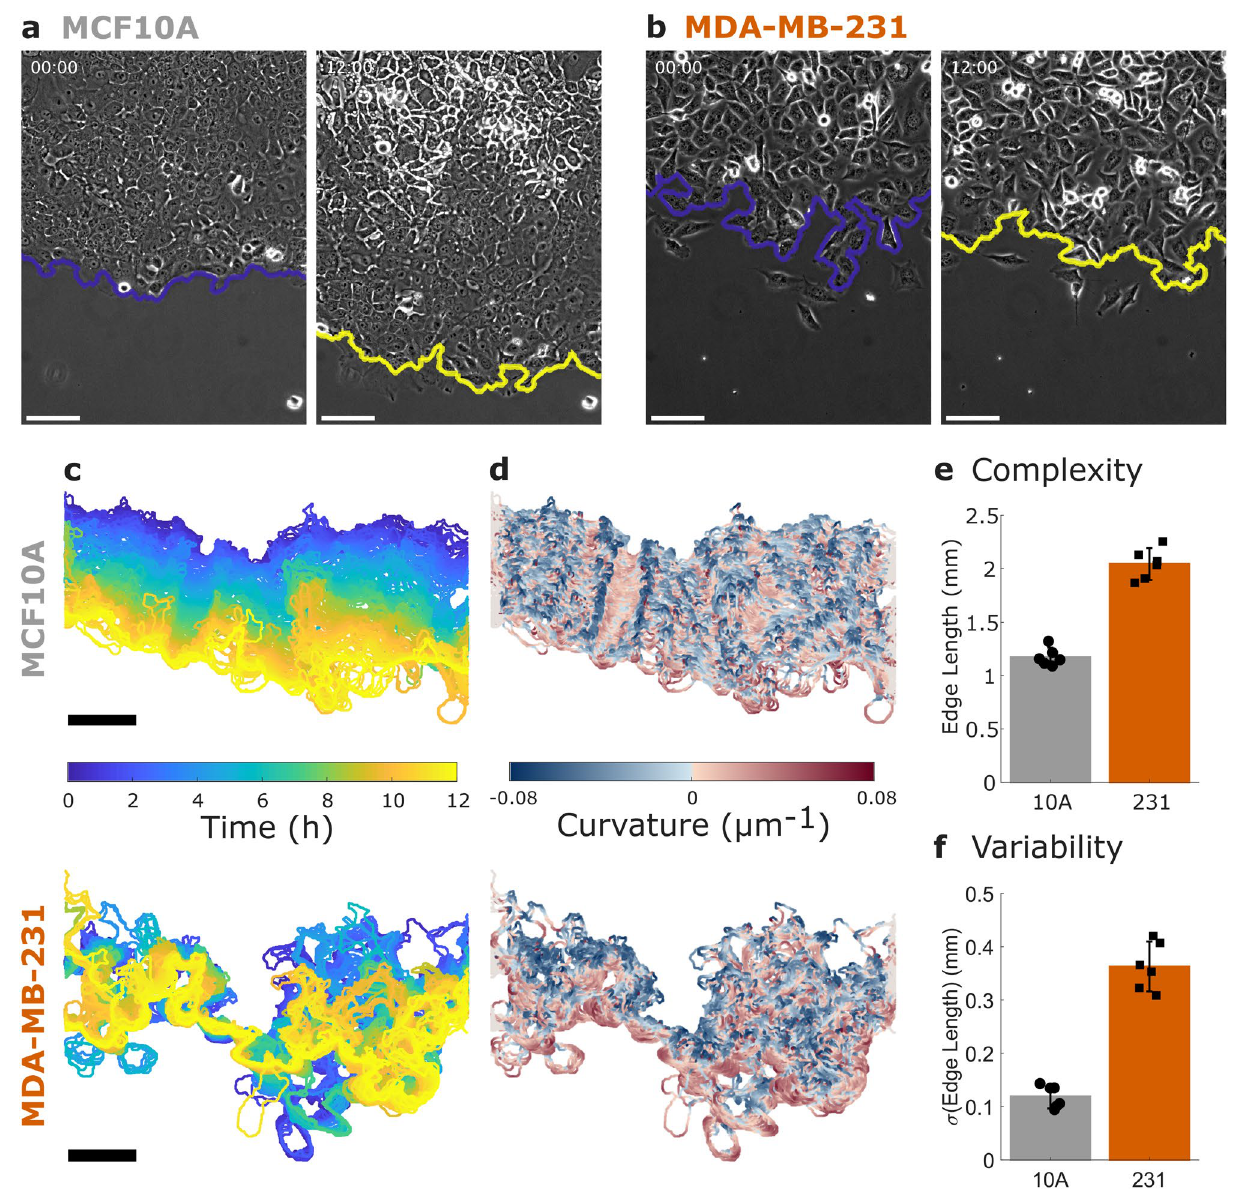
Figure 1. Collective Migration Changes During Cancer Progression. ( a ) Non-tumorigenic MCF10A cells and ( b ) metastatic MDA-MB-231 cells migrate in a collective migration assay over 12 h. The cell sheet leading edge is indicated by a blue (initial) or yellow (12 h) line and scale bars are 100 µm. See also Supplementary Video S1. ( c ) The dynamics of the leading edge are collective in the MCF10A cells (top) but disordered in the MDA-MB-231 cells (bottom). ( d ) Coloring the leading edge by curvature shows persistence of local features in the MCF10A cells (top) and disorder in the MDA-MB-231 cells (bottom). ( e ) Edge length quantifies the complexity of the leading edge. ( f ) Variability in edge length over time quantifies the dynamics of the leading edge. N = 6 independent experiments. Error bars indicate 95% confidence